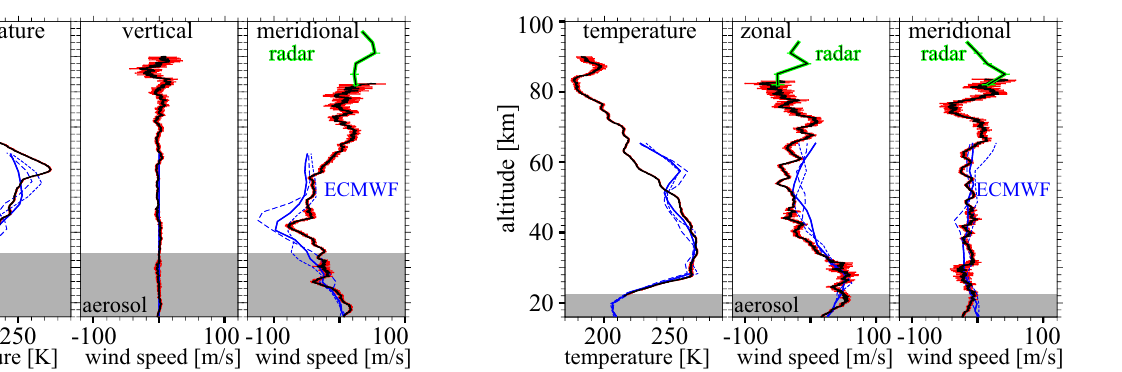
Fig. 9. Temperature, vertical and meridional wind on 17 January 2009 between 17:00 and 19:00UT. ECMWF data from 18:00UT (solid) and 12:00,24:00UT (dashed) are shown. Simultaneous ob- servations by the collocated Meteor radar are shown. The gray area indicates altitudes with aerosol contribution as measured by the lidar.